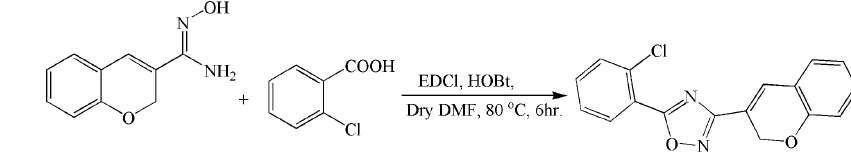
Figure 4 The synthetic scheme for the title